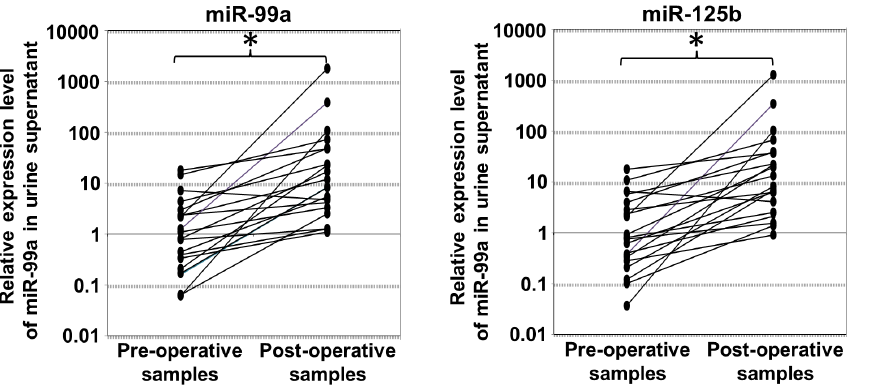
Figure 4. Restored expression of microRNA-99a and microRNA-125b in the urine supernatant of UCB patients after transurethial resection. Urine samples were collected from 20 UCB patients before (pre-operative) and after (post-operative) transurethial resection. The total RNA was extracted from the urine supernatants and subjected to RT-qPCR to quantify the levels of microRNA-99a (left) and microRNA-125b (right). A Wilcoxon signed-rank two-related-samples test was conducted to compare the levels of microRNA-99a and microRNA-125b between the pre- and post-operative samples. * denotes p , 0.01.